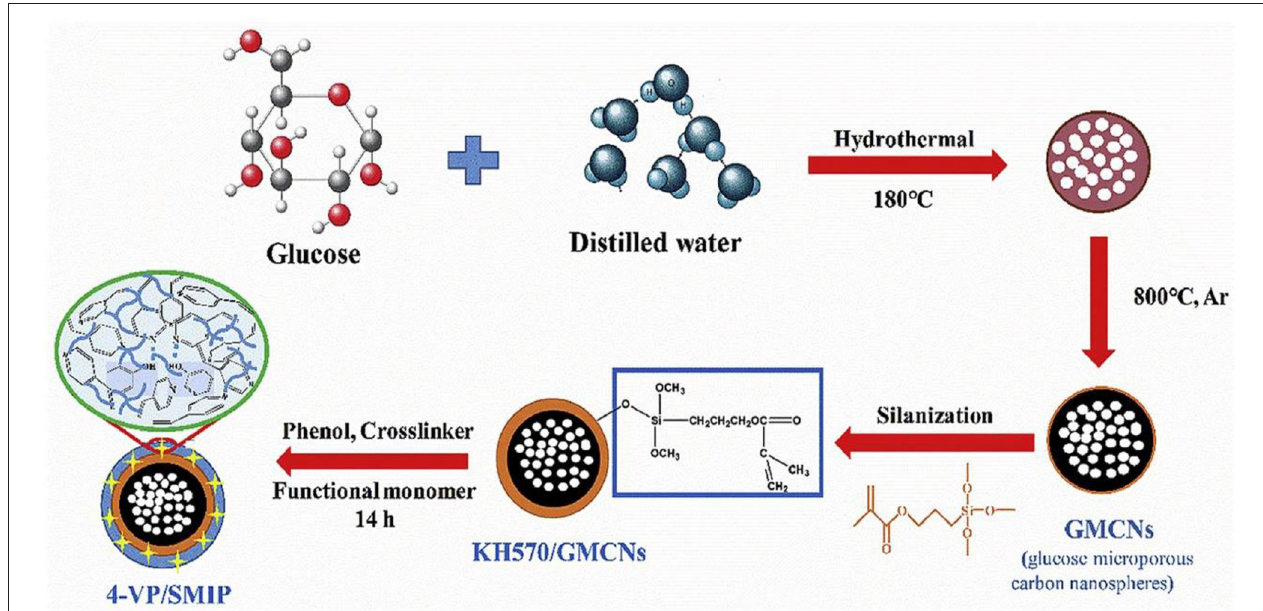
FIGURE 6 | Schematic diagram of the synthesis of surface molecularly imprinted polymers based on glucose-derived microporous carbon nanoparticles (Qu et al., 2020). Reprinted with permission from Elsevier. Copyright (2020)